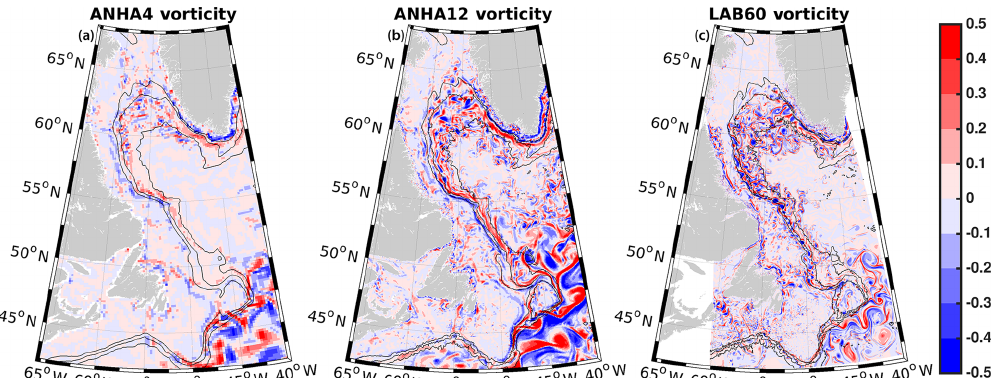
Figure 6. Top 50m relative vorticity, normalized by the planetary vorticity, as simulated by (a) ANHA4, (b) ANHA12, and (c) LAB60 on 16 March 2008. The 1000, 2000, and 3000m isobaths are shown by the black contour